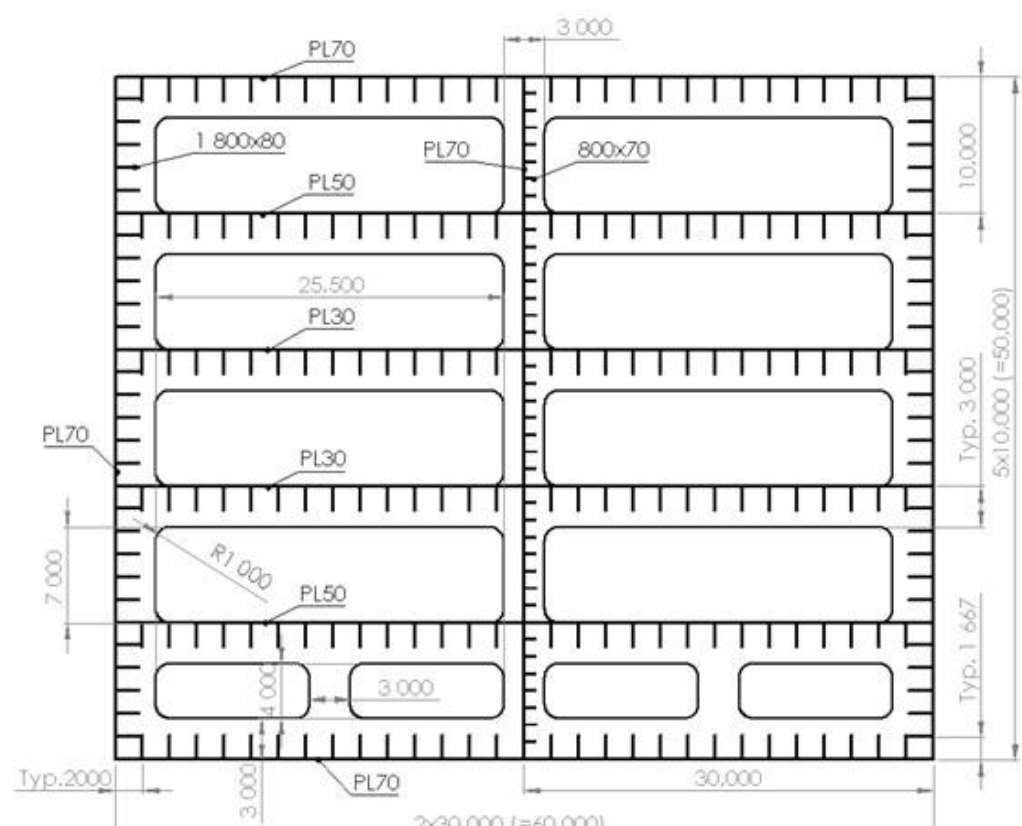
Figure 15. Initial scantling presented at the critical cross section. The plate thicknesses and stiffeners’ dimensions and spacing are typical for the entire structure. All dimensions are in millimeters.